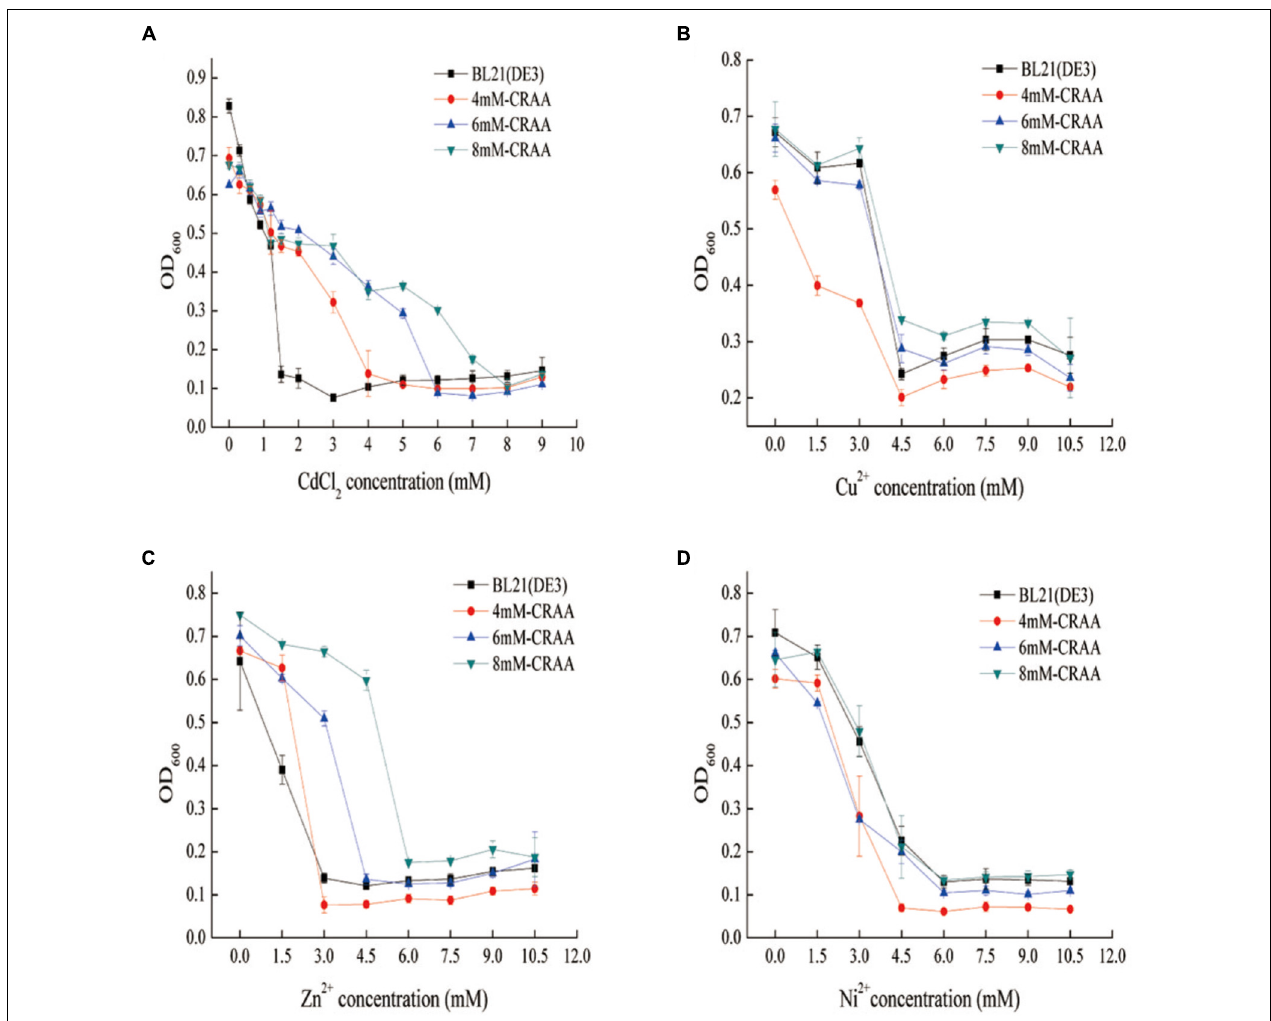
FIGURE 2 | Determination of different heavy-metal resistance mechanisms in the mutant strains. (A) Resistance of mutant strains to Cd 2 + . (B) Resistance of mutant strains to Cu 2 + (CuCl 2 ). (C) Resistance of mutant strains to Zn 2 + (ZnSO 4 ). (D) Resistance of mutant strains to Ni 2 + (NiSO 4